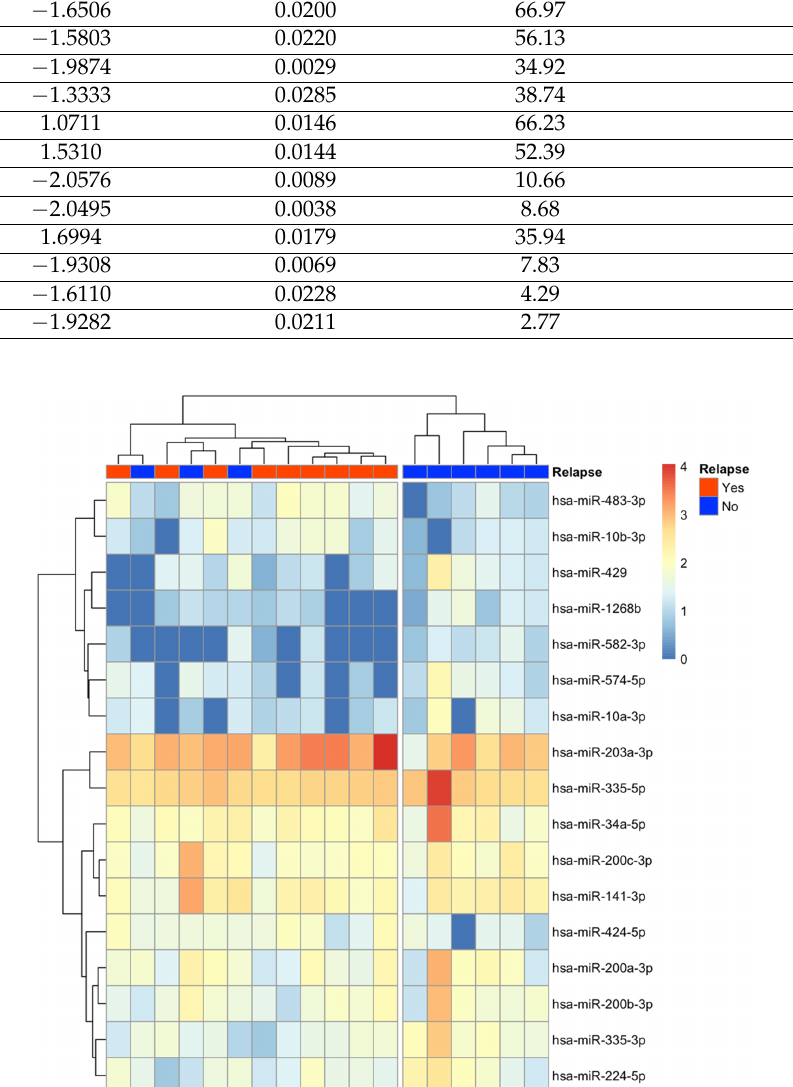
Figure 2. Hierarchical cluster analysis showing the expression of the 17 differentially expressed miRNAs between relapsed and non-relapsed patients. Log10 TMM was drawn, and Pearson correlation was used as clustering distance.